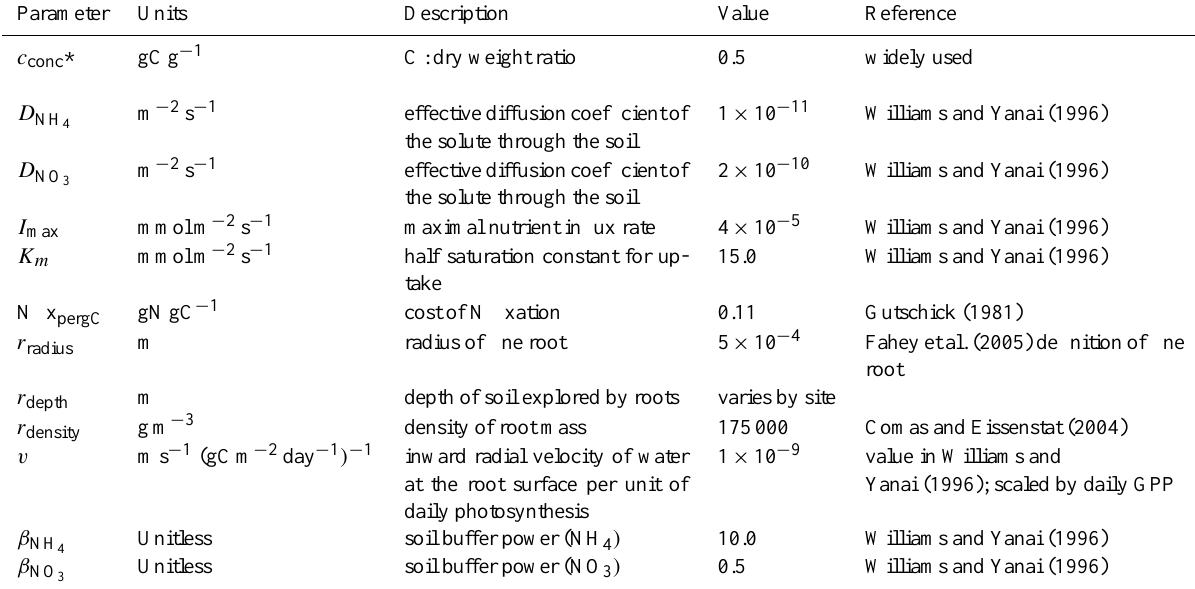
Table 4. Nitrogen uptake parameters, including units, nominal values and their sources. Parameter Units